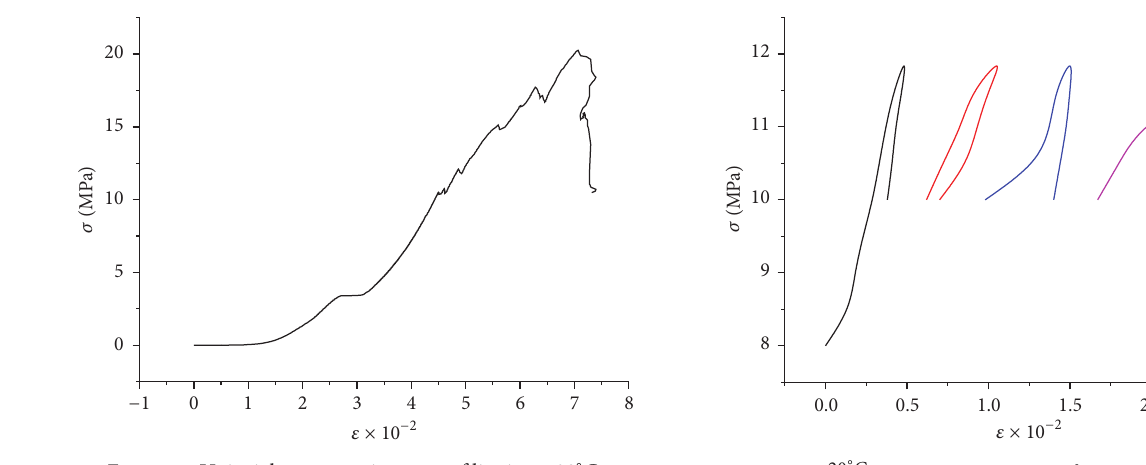
Figure 5: Uniaxial stress-strain curve of lignite at 20 ∘ C.